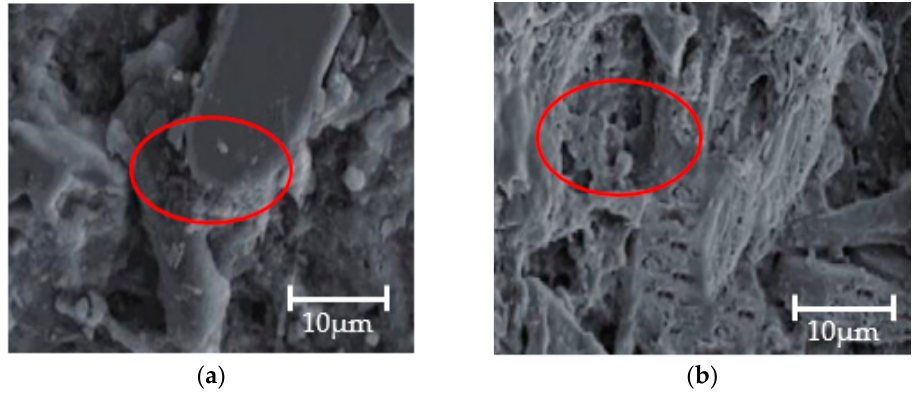
Figure 12. Microstructure of concrete after soaking ( a ) W group; ( b ) S group.